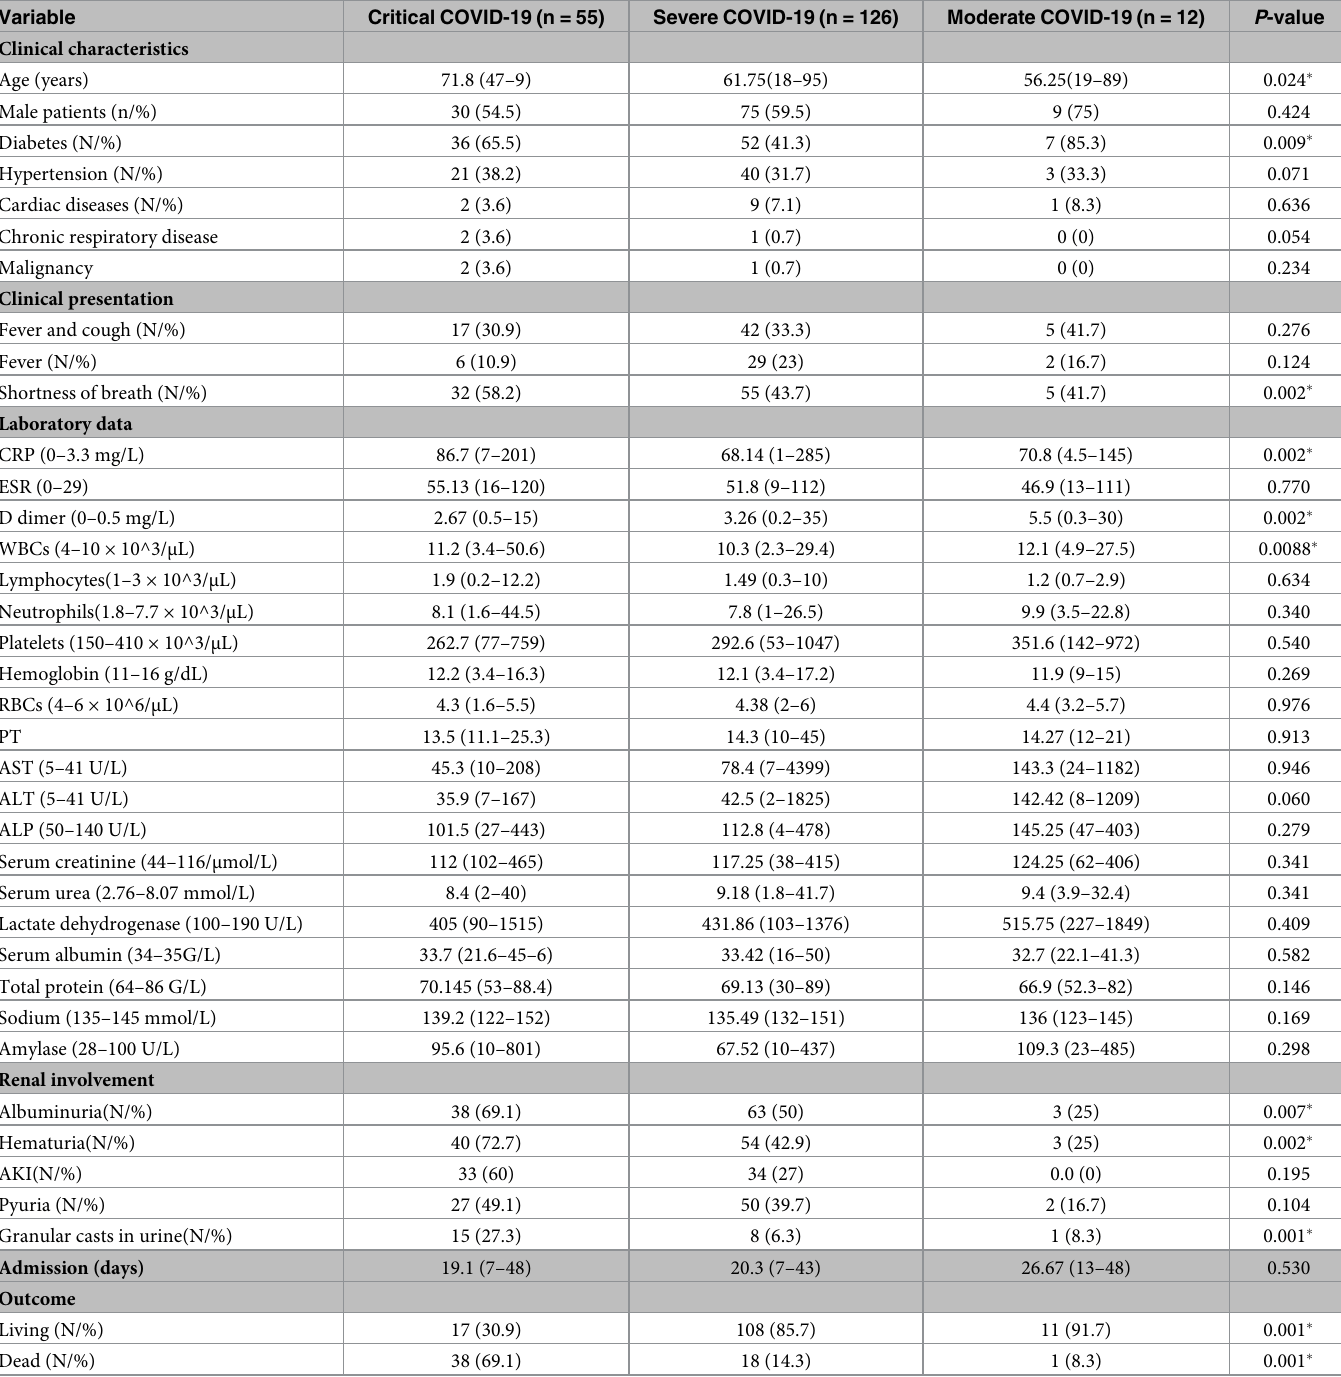
Table 1. Sociodemographic, laboratory, and clinical data of the patients with